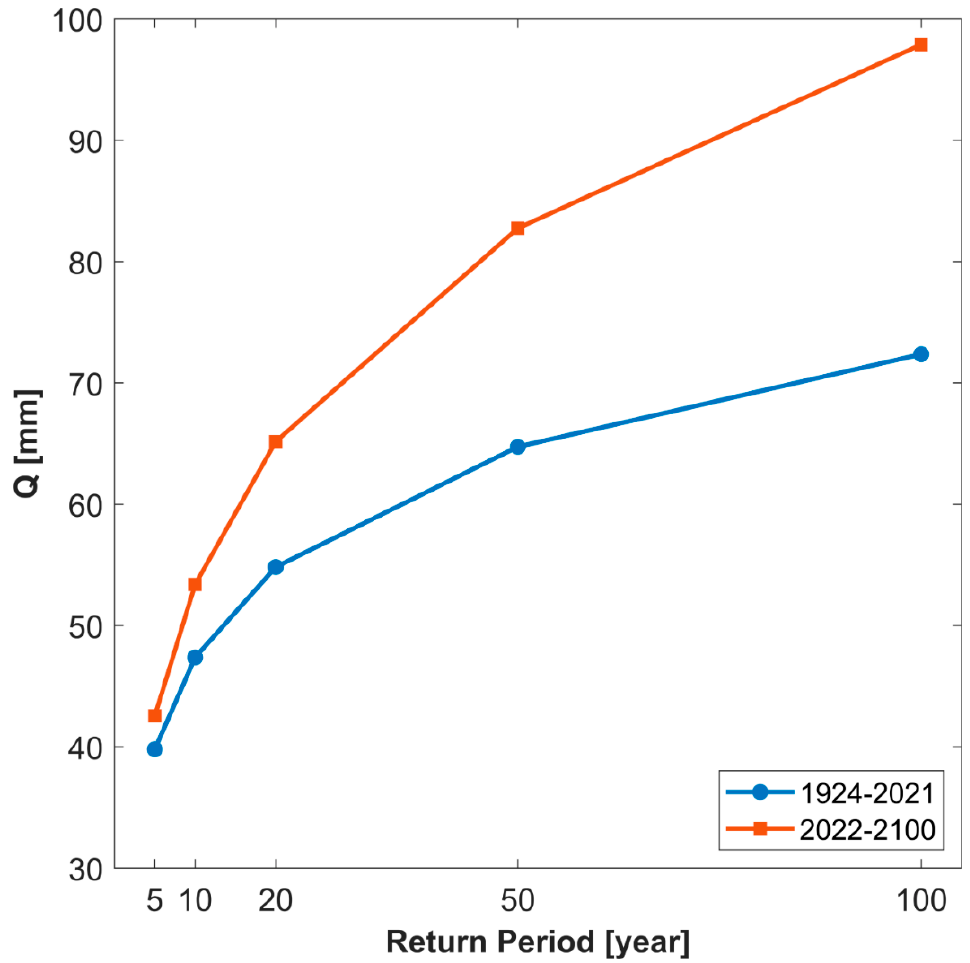
Figure 10. In the Rio Fluminimaggiore basin, the changes of daily runoff extremes under climate change: runoff values corresponding to different return periods estimated using the Generalized Extreme Event (GEV) distribution fits to historical observed data (1924–2021), and future climate scenario predictions (2022–2100, using HAdGEM2-AO predictions under RCP 85 concentration pathway). Table 5. Results of the statistical tests (Chi-square and Kolmogorov − Smirnov tests) of the General- ized Extreme Value distribution fitting to the annual maximum daily runoff time series of the Fluminimaggiore basin for the past (1924–2021) and the future climate scenario (2022–2100), pre- dicted using HadGEM2-AO data in the RCP 85 configuration. Statistics of the Chi-square and Kol- mogorov − Smirnov tests for normality, applied to the series, have 5% significance level. Period